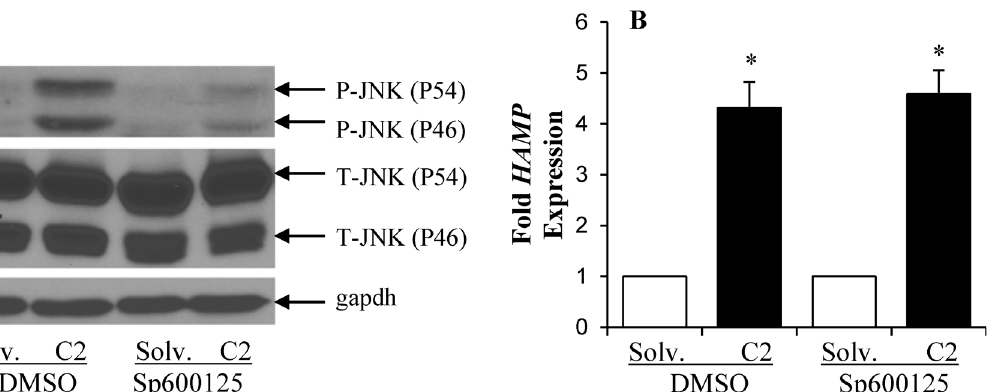
Fig 6. Ceramide-induced HAMP up-regulation was not dependent on c-Jun N-terminal kinase (JNK) phosphorylation. HepG2 cells treated with ceramide or solvent in the presence of 50 μ M chemical JNK inhibitor, Sp600125 or DMSO (control) were used to isolate protein ( A ) for western blotting to determine phosphorylated (P-JNK) and total JNK protein (T-JNK) levels using specific antibodies or to isolate RNA ( B ) to determine HAMP mRNA expression by Taqman qPCR. HAMP expression in ceramide-treated cells was calculated as fold expression of that in respective control cells treated with solvent. Asterisks indicate statistical significance (P <